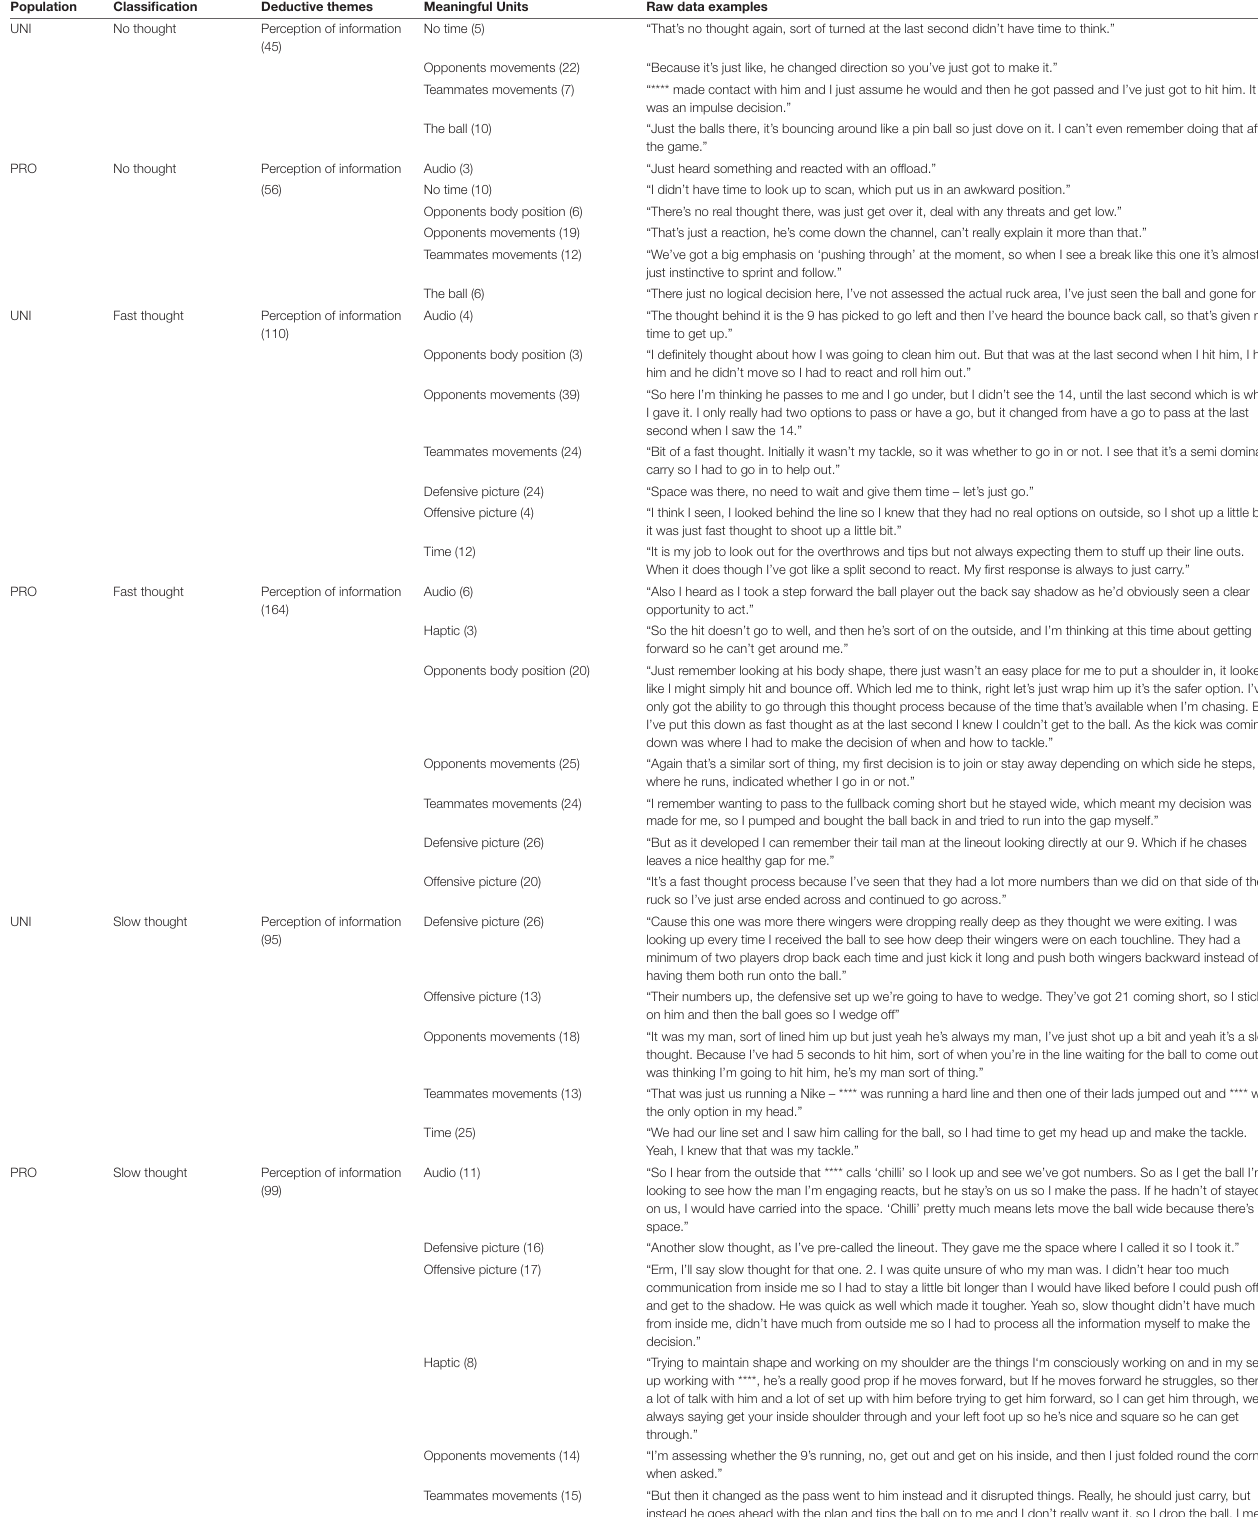
TABLE 3 | Thematic analysis of UNI and PRO Rugby Union players verbalisations of their decision making process [ number in brackets denotes the number of references made to theme